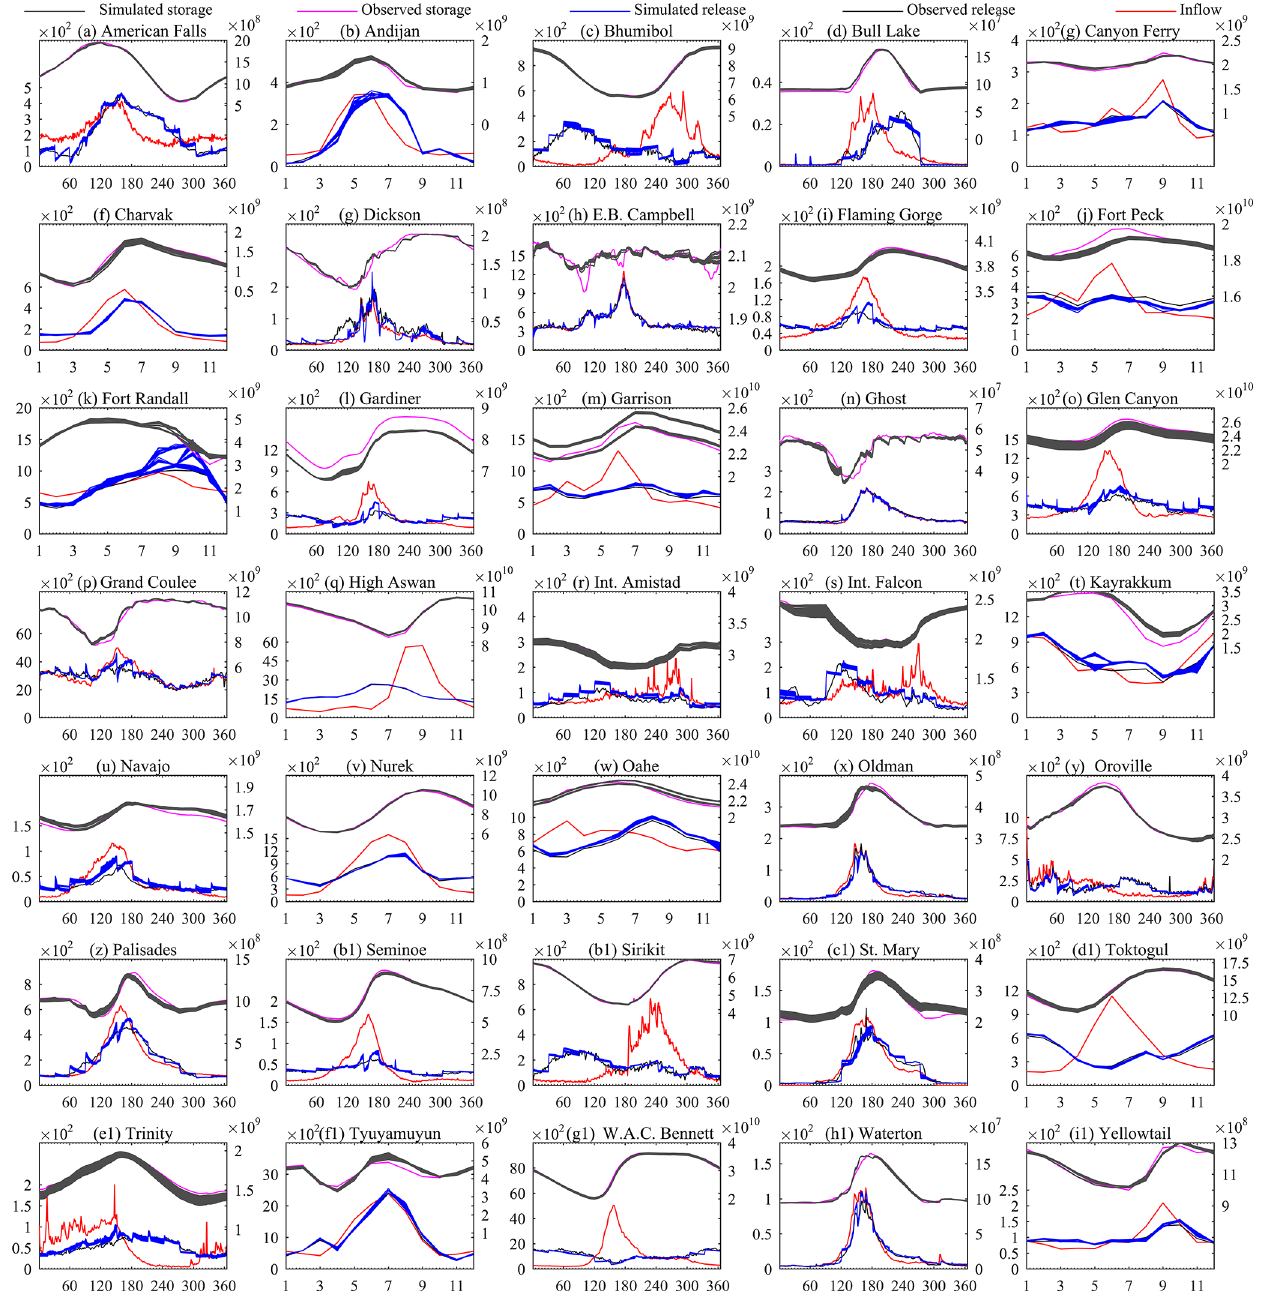
Figure 14. Long-term average daily or monthly reservoir simulations with generalized parameterization; the x axes show days (1–365) or months (1–12), the primary y axes show release (m 3 s − 1 ), and the secondary y axes show storage (m 3